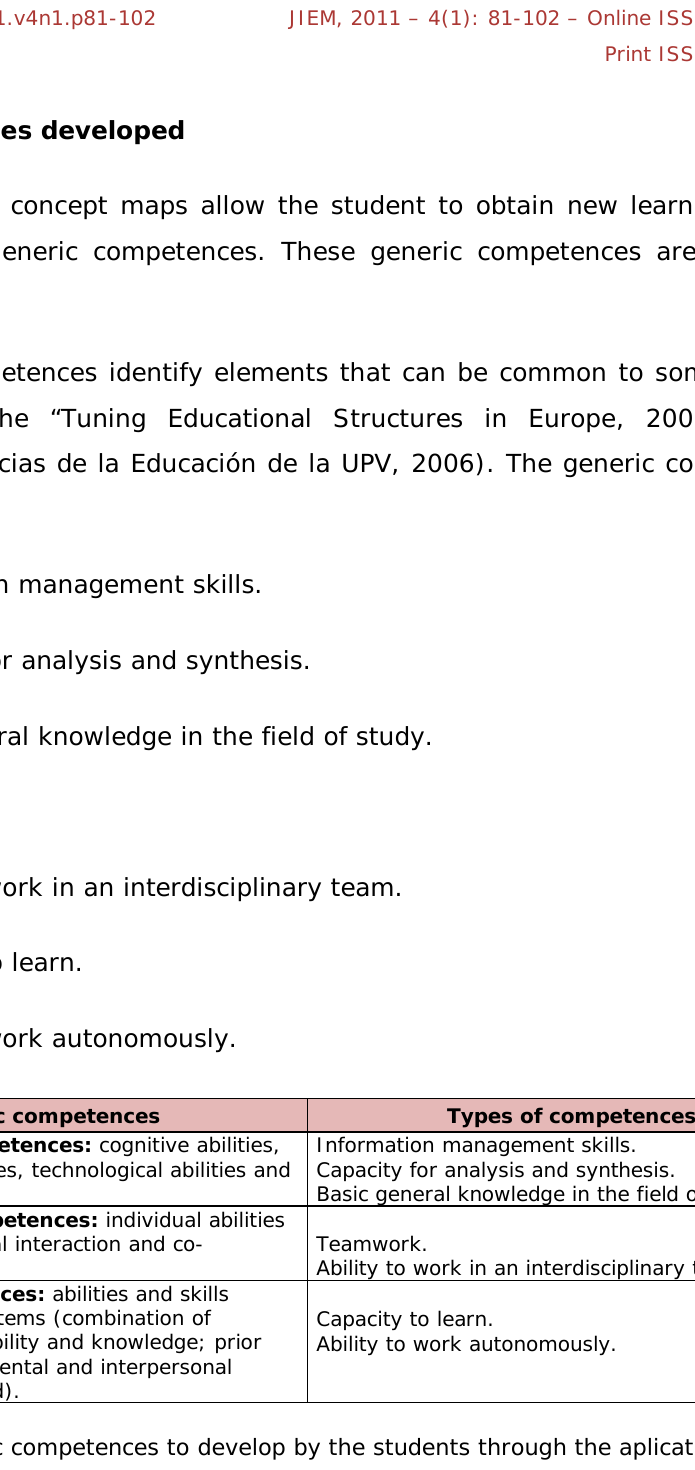
Table 5. “Generic competences to develop by the students through the aplication of the concept